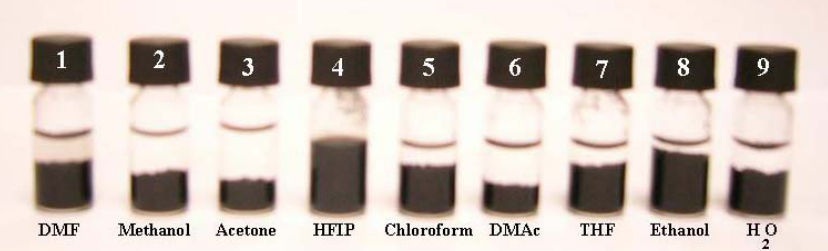
Figure 1. Images of vials taken one month after the dispersion of 7.5 mg of MWCNTs in 2 mL of various solvents. The MWCNTs dispersed in HFIP (bottle number 4) has demonstrated best dispersion and greater